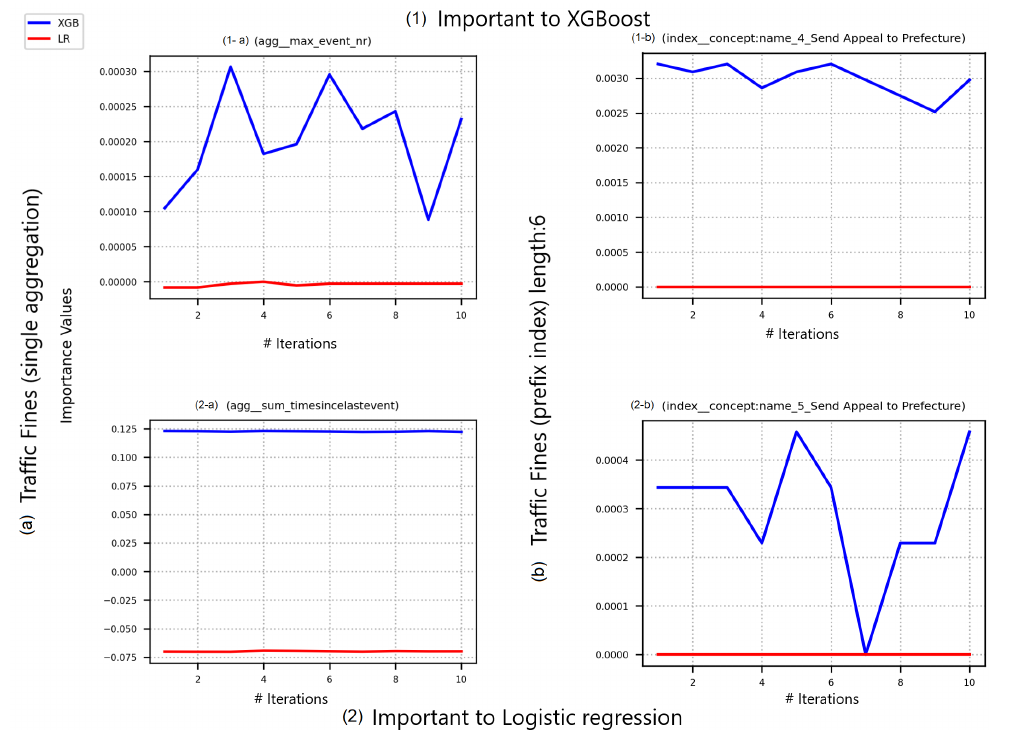
Figure 3. PFI scores over Traffic_fines event